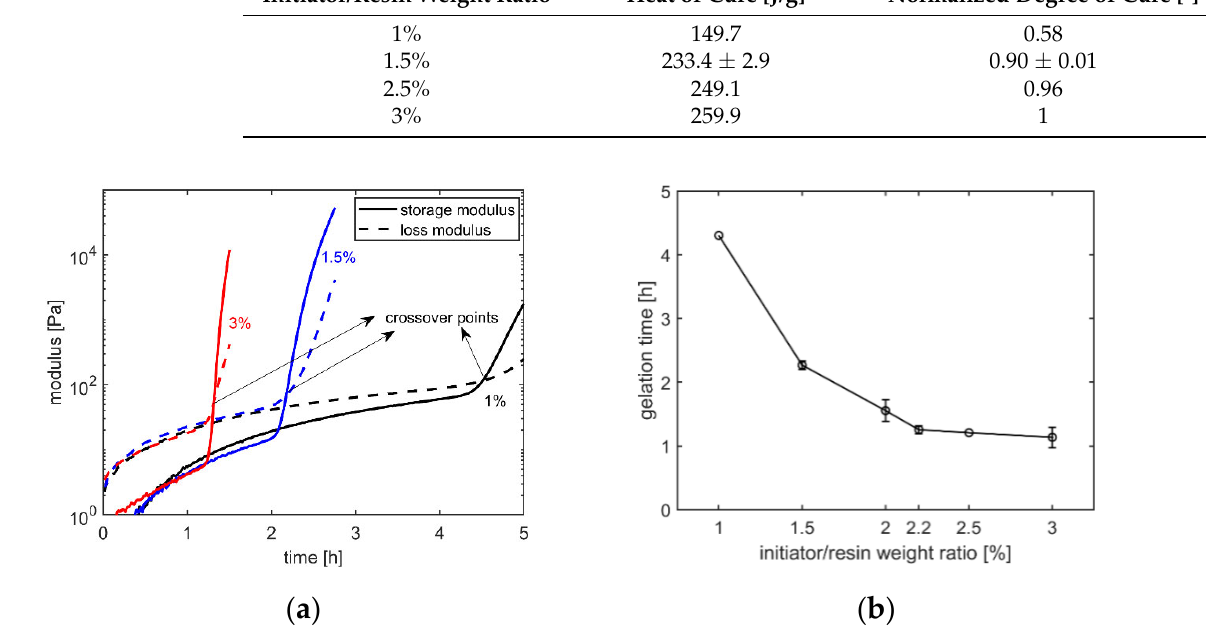
Figure 3. ( a ) The evolution of storage and loss modulus with time in rheometer tests and ( b ) gelation times of UPR-MEKP mixture for different MEKP/UPR weight ratios. Markers represent mean values and error bars represent ± one standard deviation (no error bar at 1% and 2.5%, since only 2 specimens were tested at these ratios).